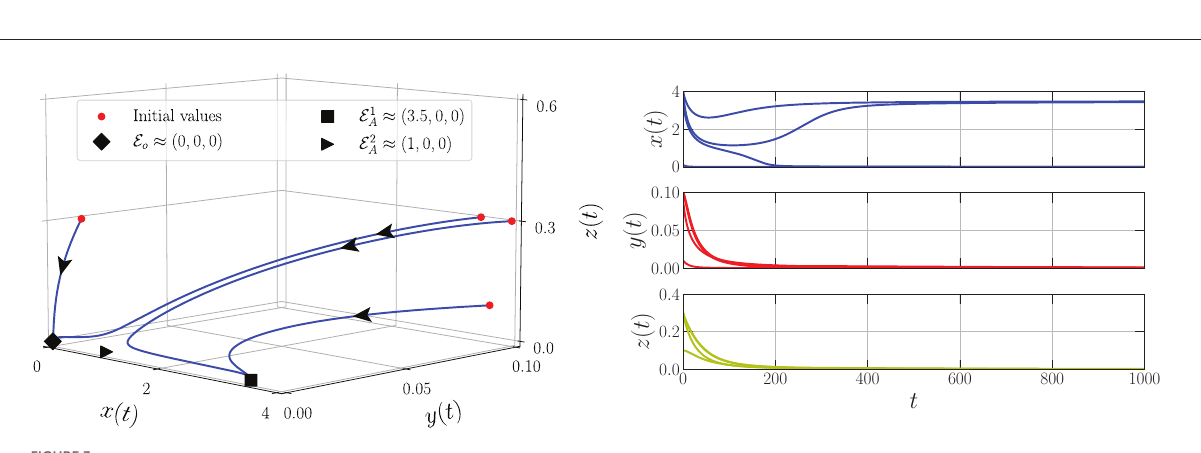
FIGURE3 Phase portrait and time series of the model (Equation 3) using parameter values: r = 0.1, K = 5, m = 0.25, c = 0.5, n = 0.01, β = 0.06, δ 1 = 0.05, δ 2 = 0.05, ω = 0.1, α = 0.9, and h =